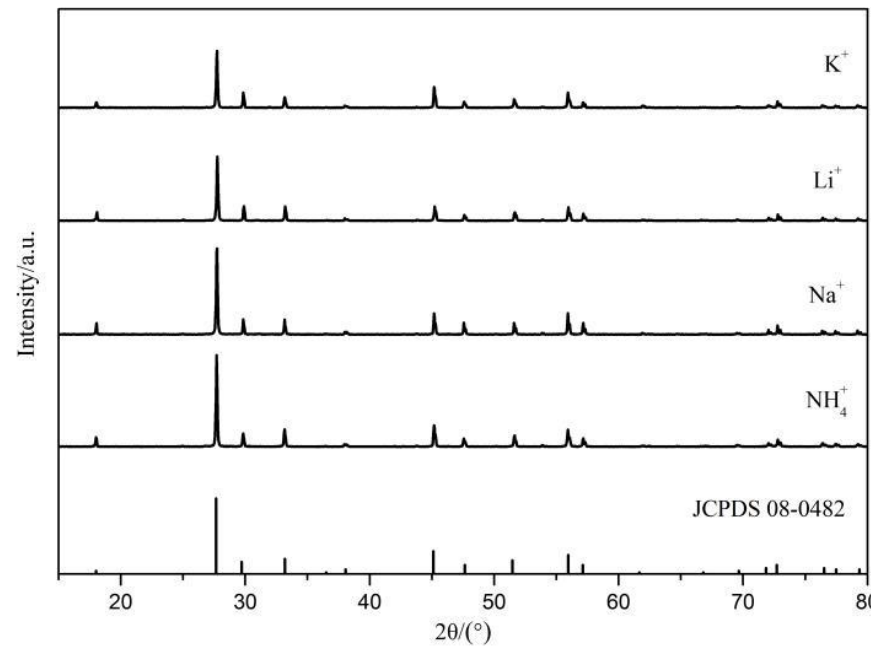
Figure 3. XRD of Sr 0.99 Mo 0.5 W 0.5 O 4 :0.01Eu 3+ with different charge compensators.